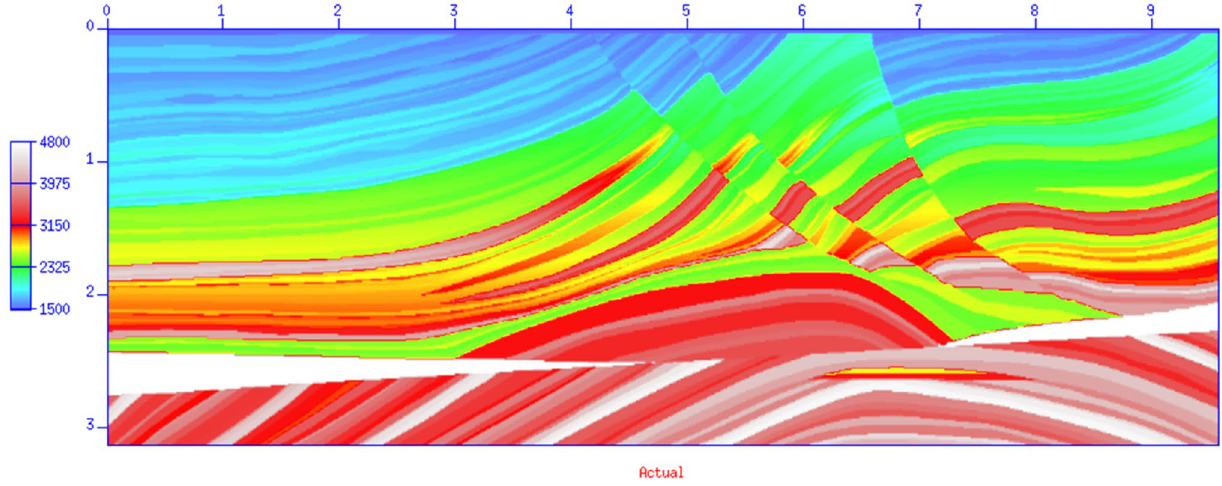
Fig. 1 Illustration of the velocity model of the Marmousi